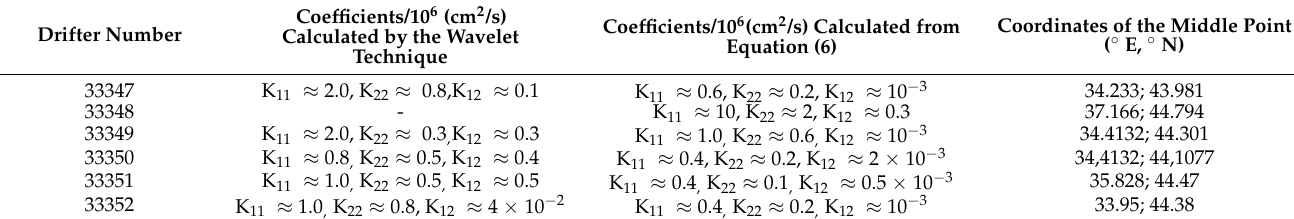
Coordinates of the Middle Point ( ◦ E, ◦